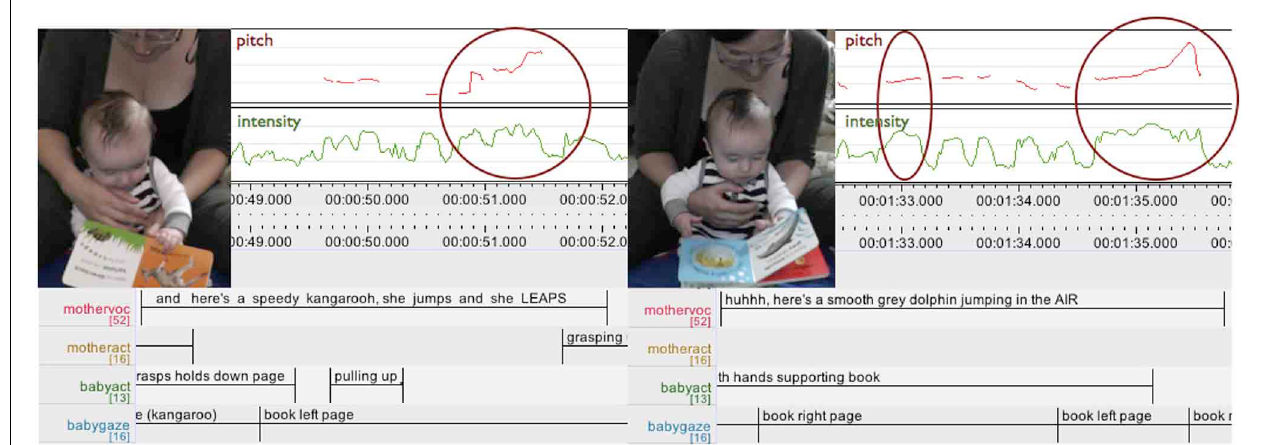
FIGURE 4 | ELAN analysis detail showing pitch (red) and intensity (green) curves. The mother is reading a picture book about animal actions to her 4-month-old son enacting the essence of “leaping” and “jumping” (a rising motion) through a rising intonation contour (highlighted).